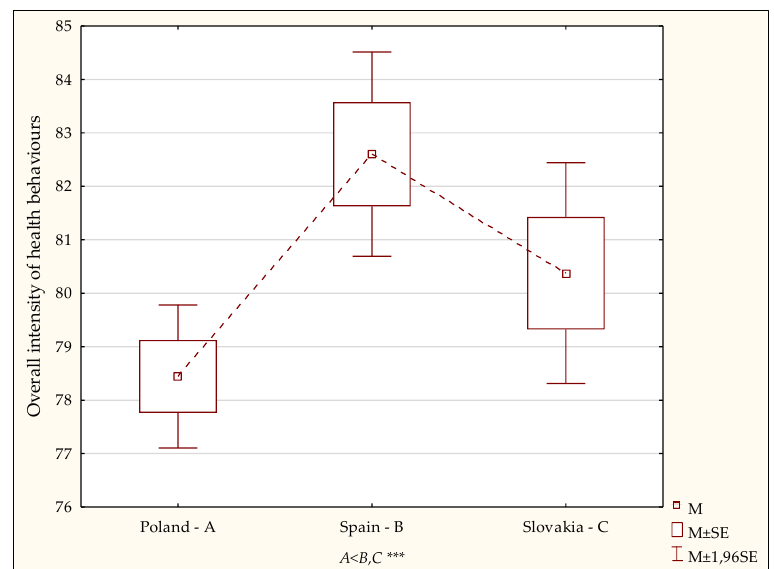
Figure 1. Overall intensity of health behaviours – diversity of scores. Statistically significant: *** p < 0.001.